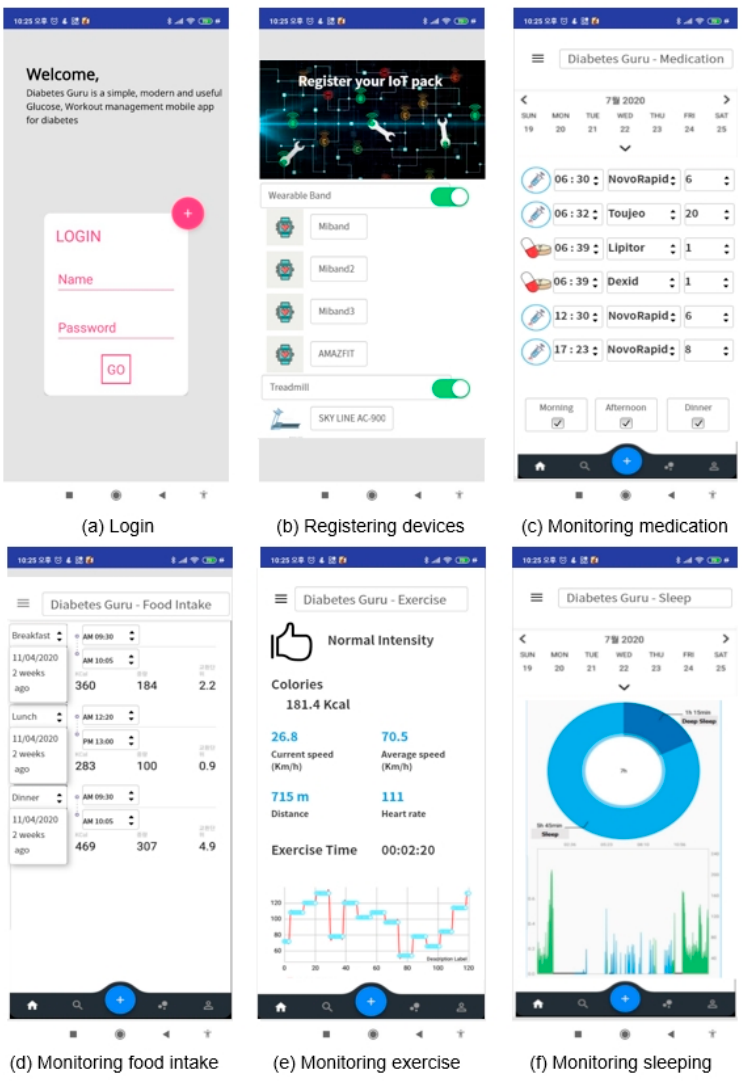
Figure 10. Implementation results of proposed self-care